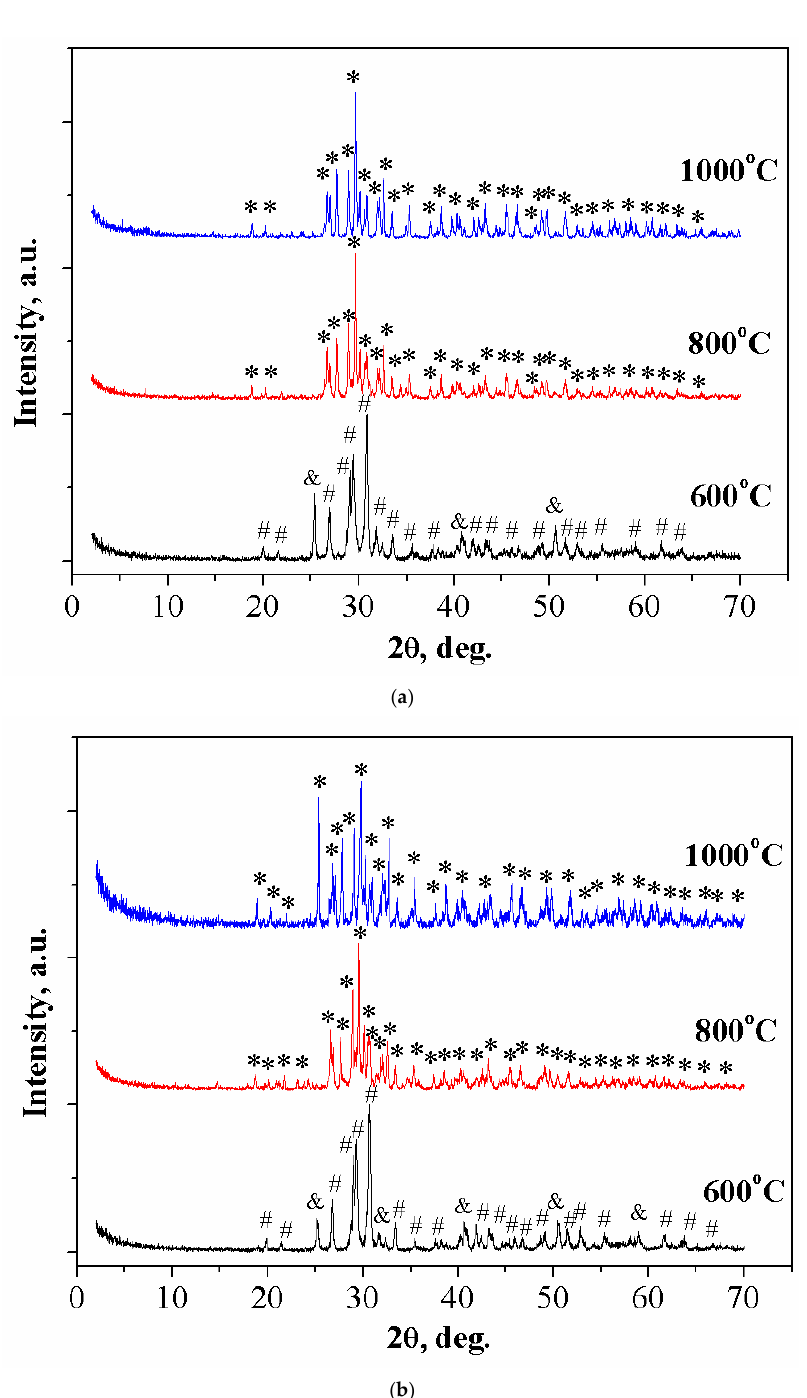
Figure 7. The XRD of ceramic materials with a weight ratio of: ( a ) Ca(PO 3 ) 2 /Ca 2 P 2 O 7 = 0/100; * —β - Ca 2 P 2 O 7 (PDF 9-346); # —γ - Ca 2 P 2 O 7 (PDF 17-499); & —β -Ca(PO 3 ) 2 (PDF 17-500). ( b ) Ca(PO 3 ) 2 /Ca 2 P 2 O 7 = 20/80 in the temperature range of 600–1000 ◦ C. The SEM images of the obtained samples after annealing at 1000 ◦ C are shown in Figure